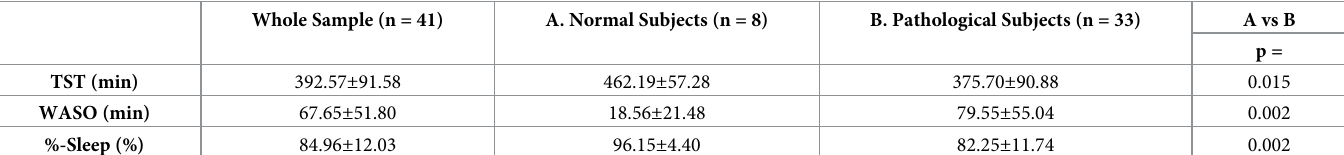
Table 2. Sleep quality